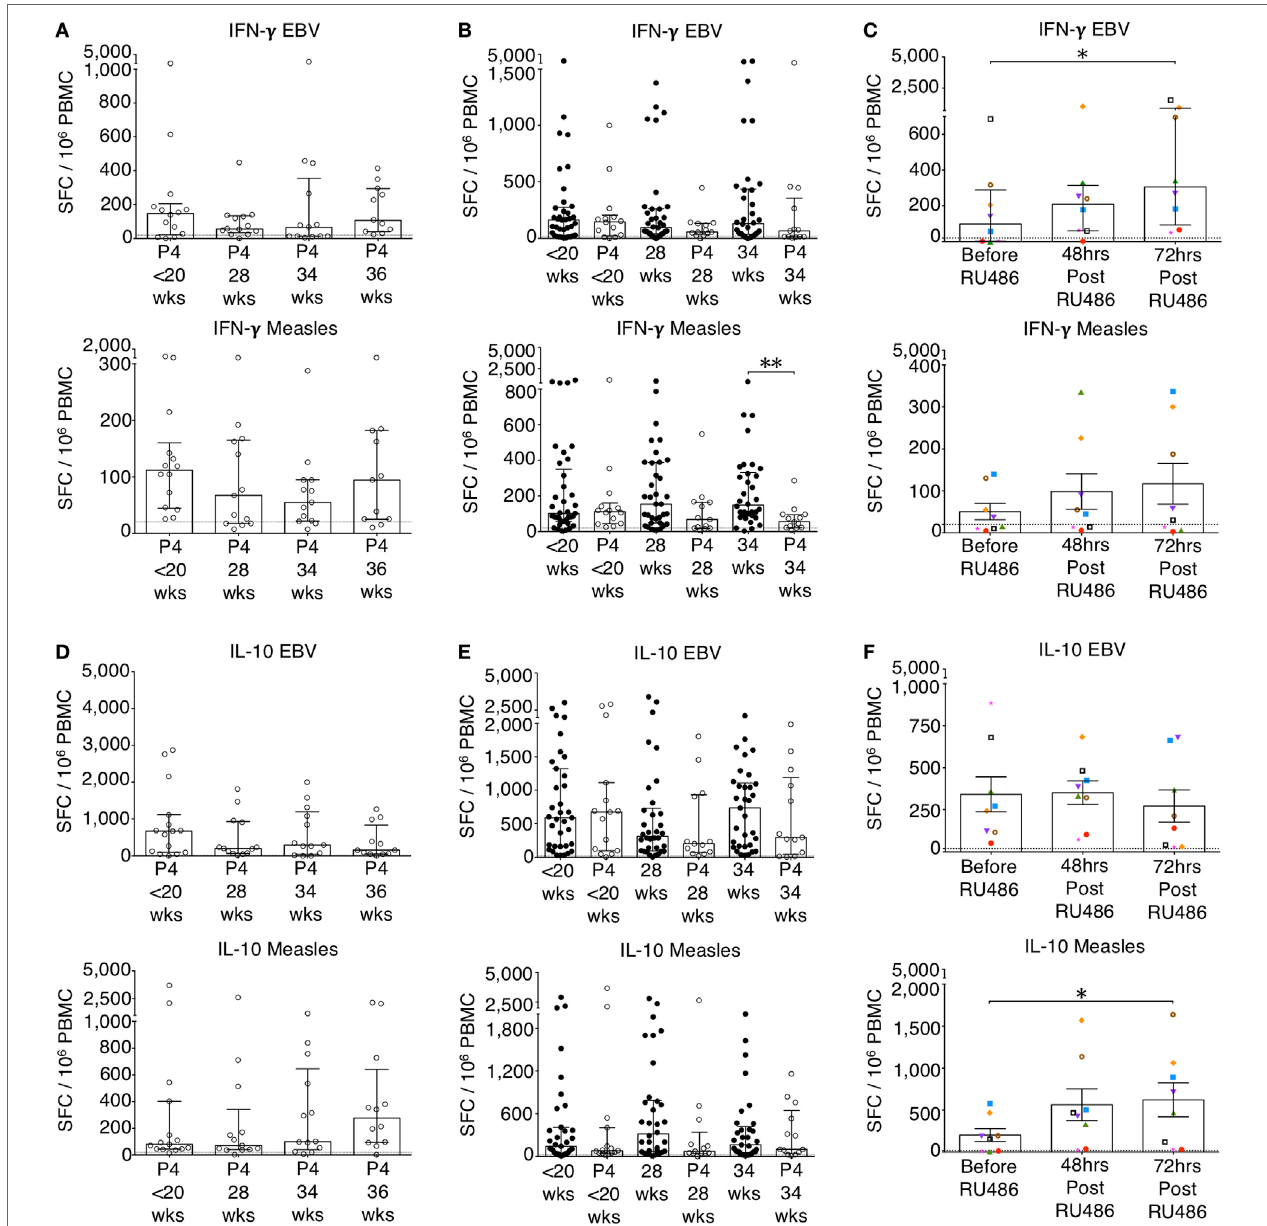
FigUre 5 | P4 supresses IFN- γ and IL-10 enzyme-linked immunospot (ELISpot) responses. EBV and measles responses are shown. (a) Longitudinal analysis of